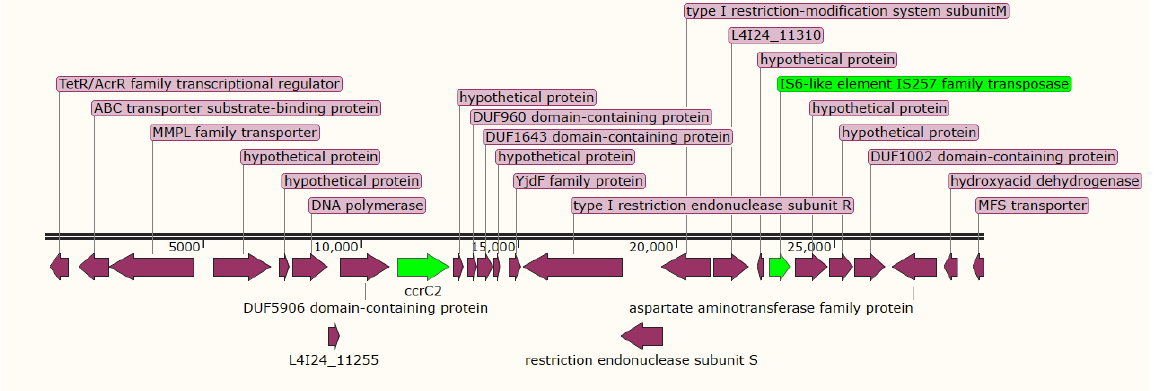
Figure 2. Schematic representation of the unique SCC in the 9SE strain, which contains ccrC2 and IS257, shown in green. The purple arrows showing other genes present in the same contig.